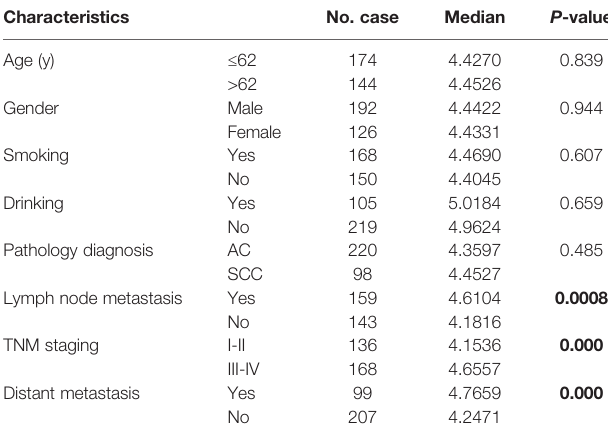
TABLE 2 | Characteristics of NSCLC patients for differentially expressed serum exosomal miR-125b-5p.